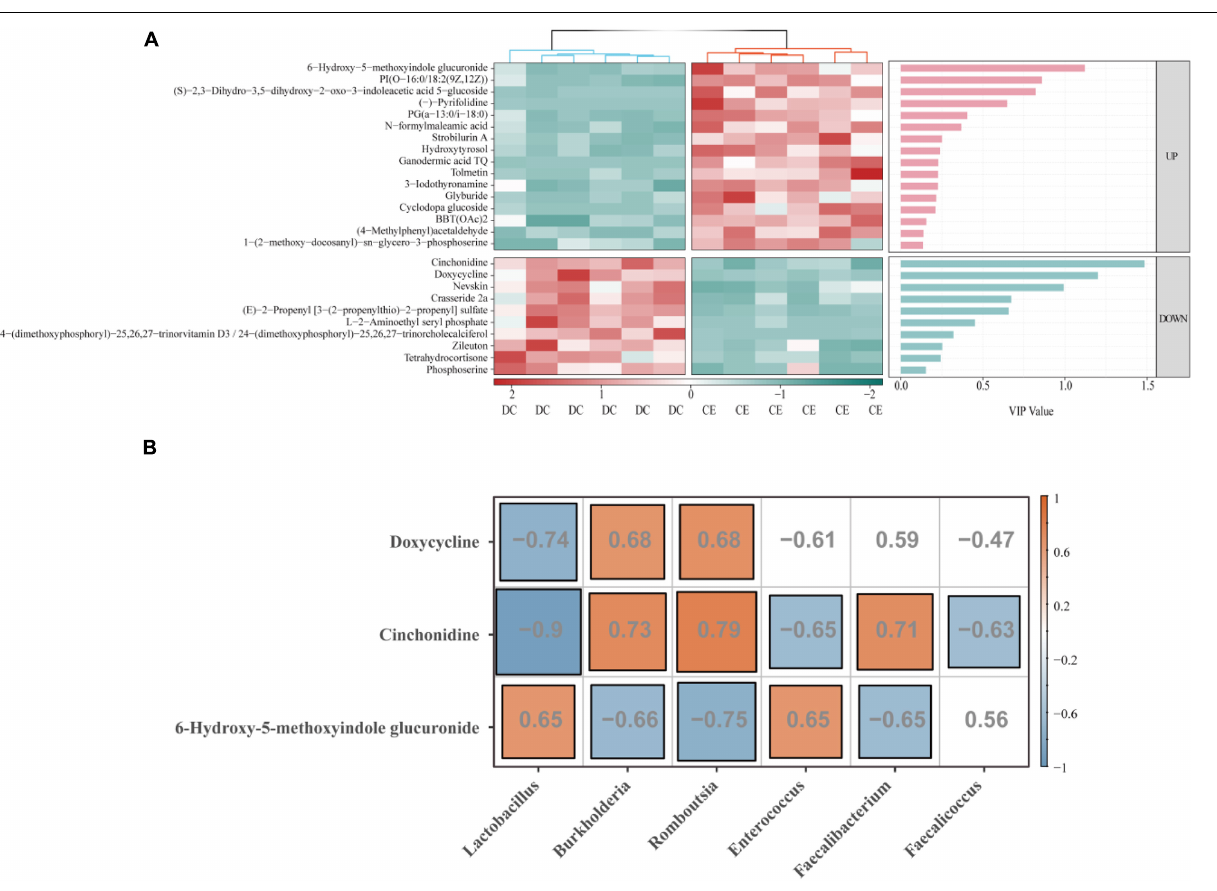
FIGURE 8 | Correlation analysis was conducted between the top focus metabolites and the signature microbiota to explore the key factors influencing organismal fitness by adding CE. (A) Heat map of differential metabolites with a bar graph of VIP values from previous OPLS-DA model. Only if the metabolites were a satisfied condition of VIP > 1 were selected for the following association analysis. (B) The correlation of top focus metabolites and the signature